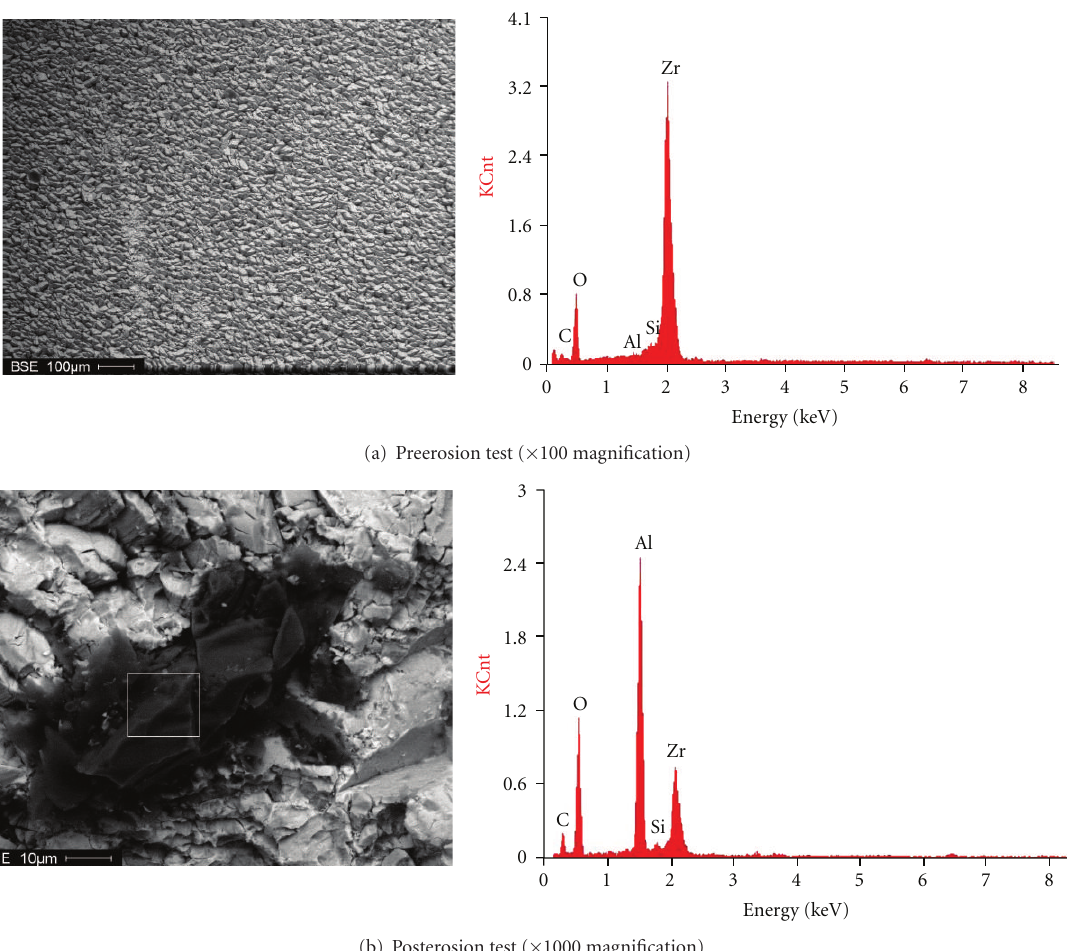
Figure 9: Sample TBC surface scans with electron microscope.